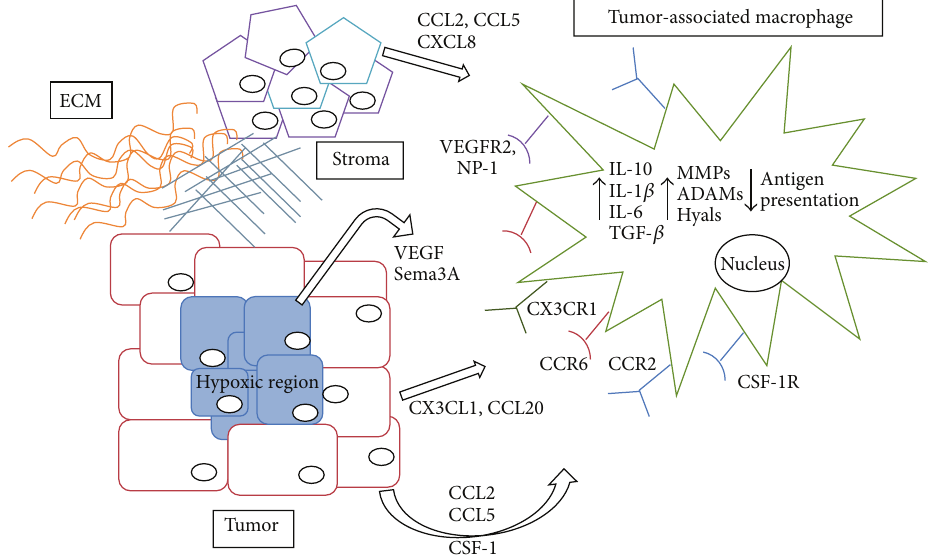
Figure 2: Complex interactions in the tumor microenvironment. Breast cancer cells located in the tumor periphery (red rectangles) secrete cytokines and chemokines, which recruit monocytes from the circulation and differentiate them into tumor-associated macrophages (TAMs). Tumor cells located in the inner, hypoxic region (blue rectangles) develop a more specialized array of molecules to recruit macrophages poised to help the hypoxic cells survive and proliferate. The stromal cells of the tumor, along with components of the extracellular matrix (such as collagen I and hyaluronan), additionally contribute to the recruitment and retention of TAMs. Once educated by the tumor microenvironment, TAMs upregulate pathways associated with both M1- and M2-activated macrophages and actively support the survival, proliferation, and metastasis of breast cancer